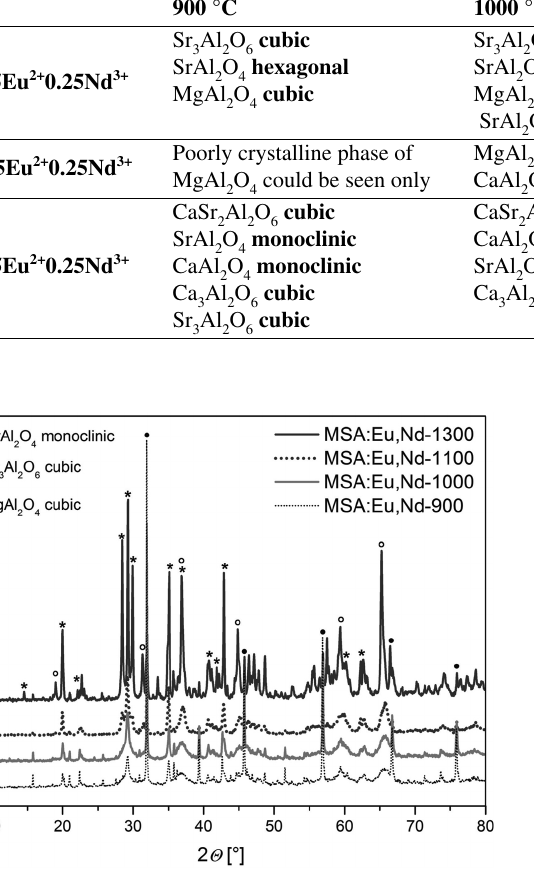
Figure 1. Crystallization and phase development with increasing temperature in a typical sample of MSA:0.5Eu 2+ ,0.25Nd 3+ , as shown by the XRD. The diffraction peaks of the individual phases are marked by symbols shown in the legend.